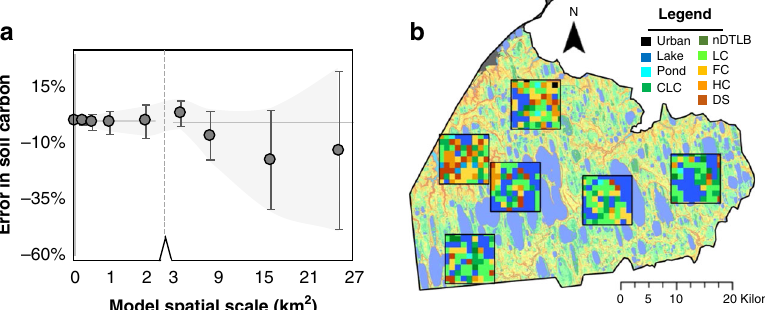
Fig. 5 Error propagation with scale. Errors of prediction in tundra soil carbon by 2100 in response to model spatial scale on the Barrow Peninsula ( a ). Simulations were computed using all tundra landforms and model spatial scales across six randomly located 75 km 2 subregions ( b ). Error metrics are visualized in a , as the deviation of simulations from 0 is representative of the bias error, and the range of simulation uncertainty (gray envelope) at each spatial scale represents the random error. Note axis break (dotted line) in a .